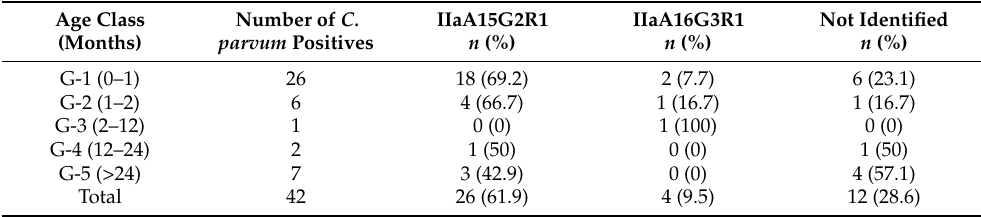
Figure 1. Prevalence of Cryptosporidium spp. and percentage of identification of Cryptosporidium species detected in healthy cattle from Galicia when the age of the animals was considered. Table 1. Cryptosporidium parvum subtypes identified in cattle from Galicia (north-western Spain) when the age of the animals was considered.